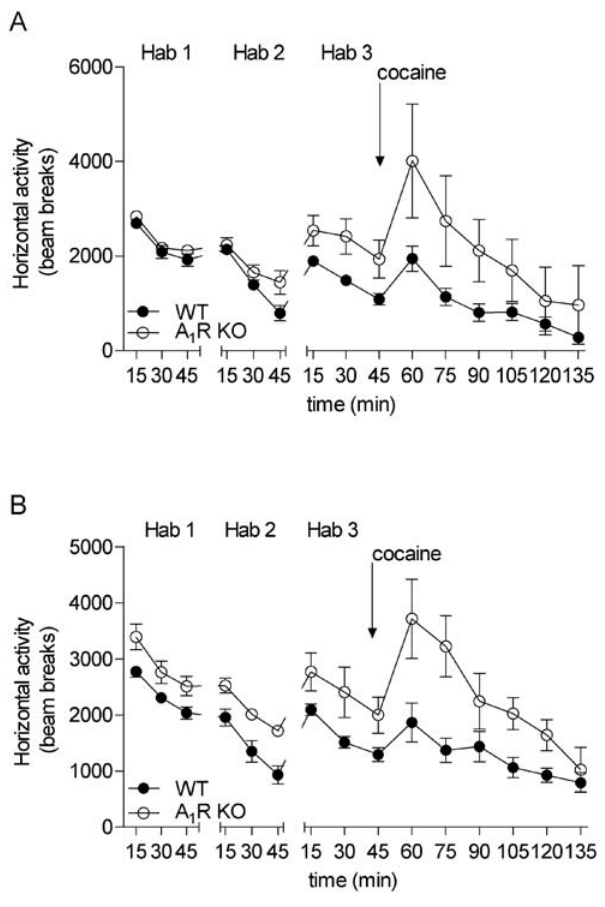
Figure 3. Open field behavior of A 1 R KO mice. During habituation 1, 2 on the first day of examination and habituation 3 (45 min), followed by 10 mg/kg cocaine injection (90 min) in WT(blackcircle) and A 1 R KO(open circle) male (A) and female (B) mice, in the second day of testing. Arrows indicates the time of cocaine injection. Each point represents the mean 6 S.E.M of the beam breaks recorded during 15 minute intervals (males WT n=10, A 1 R KO n=3; females WT n=12, A 1 R KO n=4).